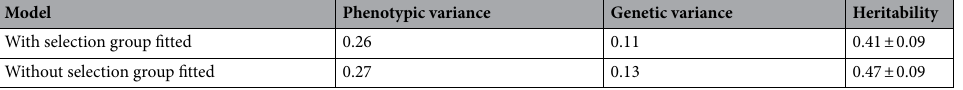
Table 3. Estimated variance components and heritabilities for “days or alive” from analysing the G 1 -data with or without selection group fitted as a fixed effect.